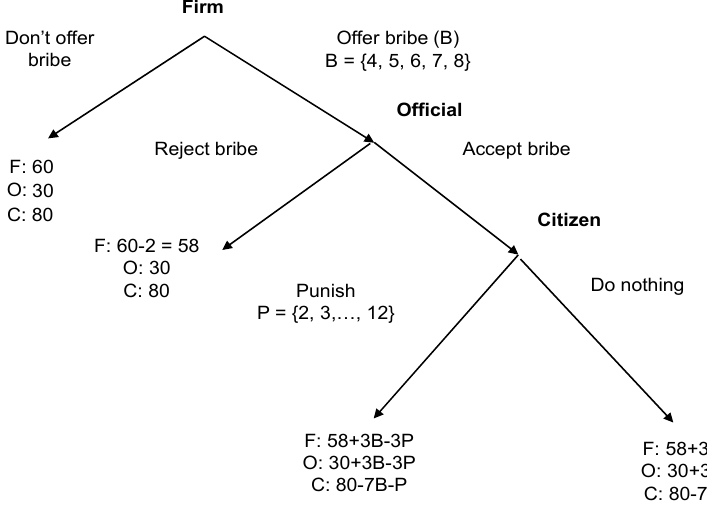
Figure 1. Structure of the experiment with loaded language.